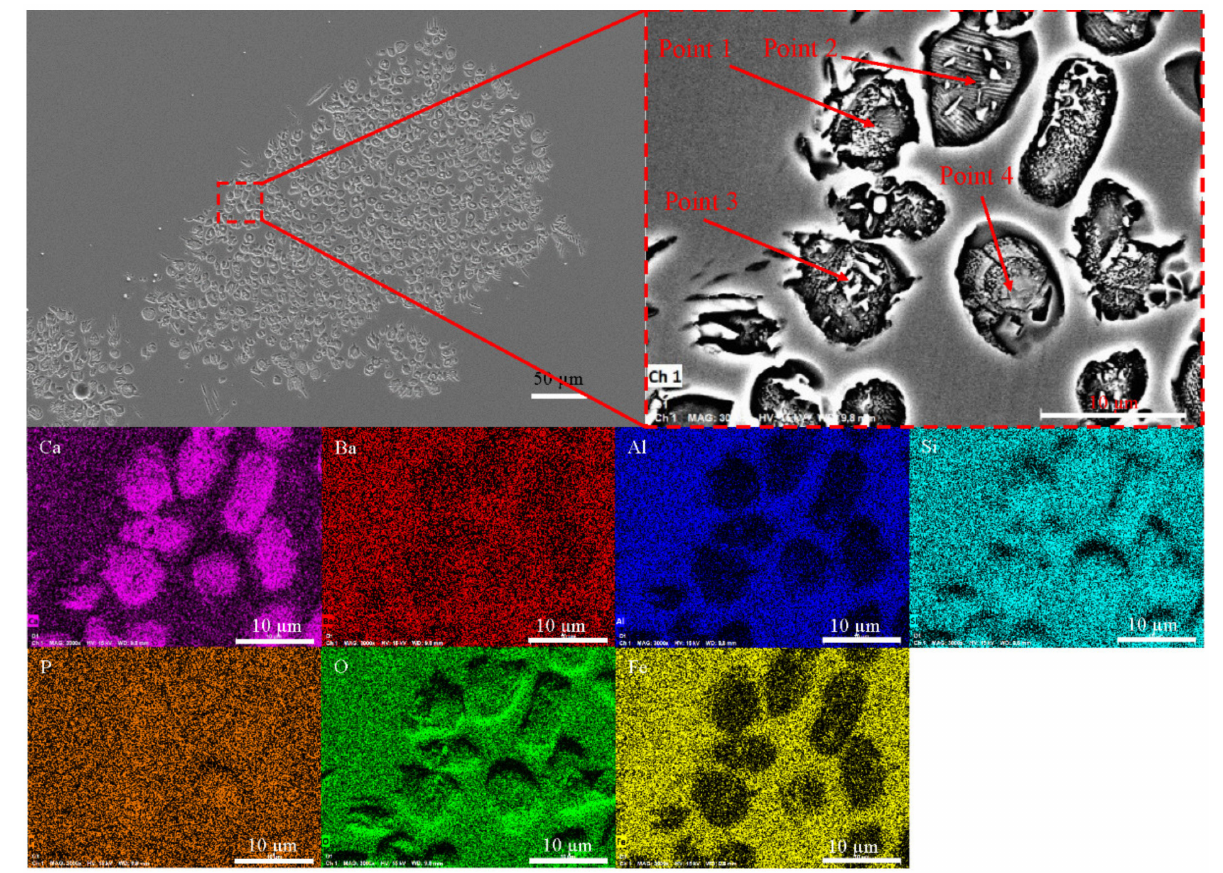
Figure 14. Area and point scan analyses by